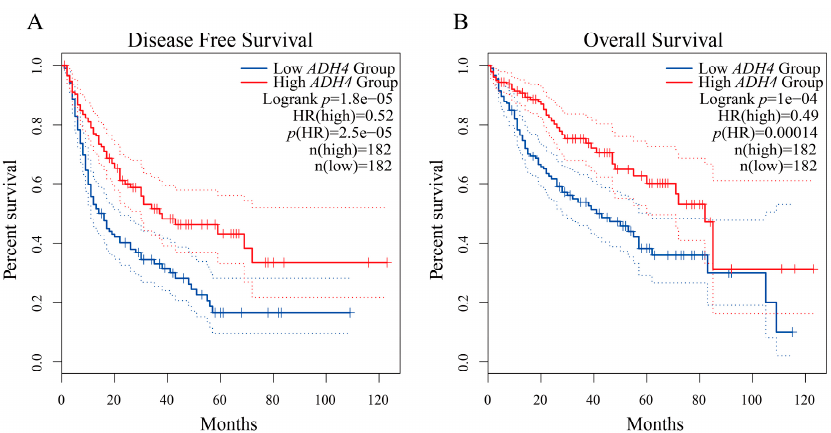
Figure 8. The prognostic value of ADH4 expression for HCC patients. Kaplan-Meier survival curves were plotted using the online GEPIA platform. ( A ) Correlation of low ADH4 expression levels with poor DFS in HCC patients. The DFS curve for patients with high ADH4 expression levels is shown by the red solid line. The DFS curve for patients with low ADH4 expression levels is shown by the blue solid line; ( B ) Correlation of low ADH4 expression levels with poor OS of HCC patients. The OS curve for patients with high ADH4 expression levels is shown by the red solid line. The OS curve for patients with low ADH4 expression levels is shown by the blue solid line. The 95% confidence intervals are shown by the dashed line. p < 0.05 in the log-rank test was considered statistically significant. Abbreviations : DFS, disease-free survival; OS, overall survival; n, number; GEPIA, Gene Expression Profiling Interactive